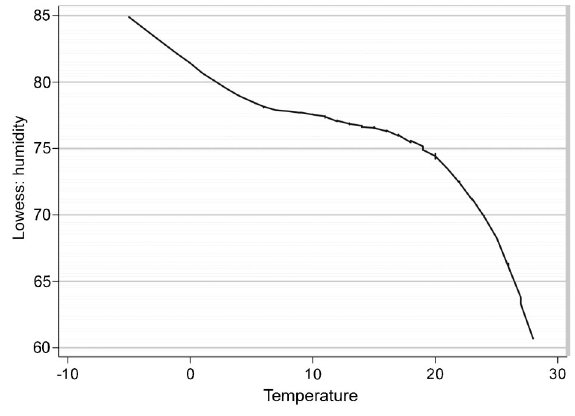
Figure 3. Relative humidity and air temperature linear associa- tion.